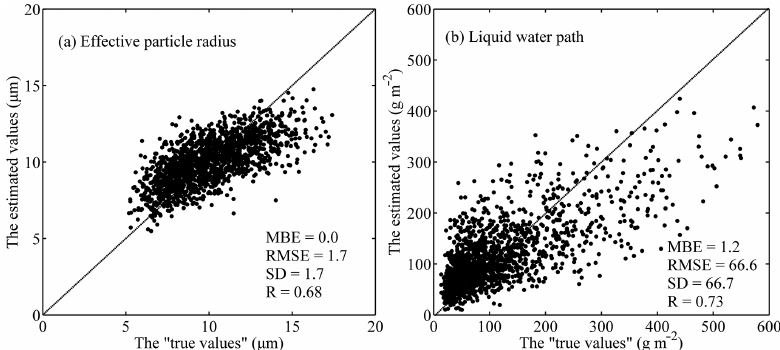
Figure 3. Comparisons of water cloud parameters between the MODIS “true values” and the estimated ones by ANN for (a) effective particle radius and (b) liquid water path.